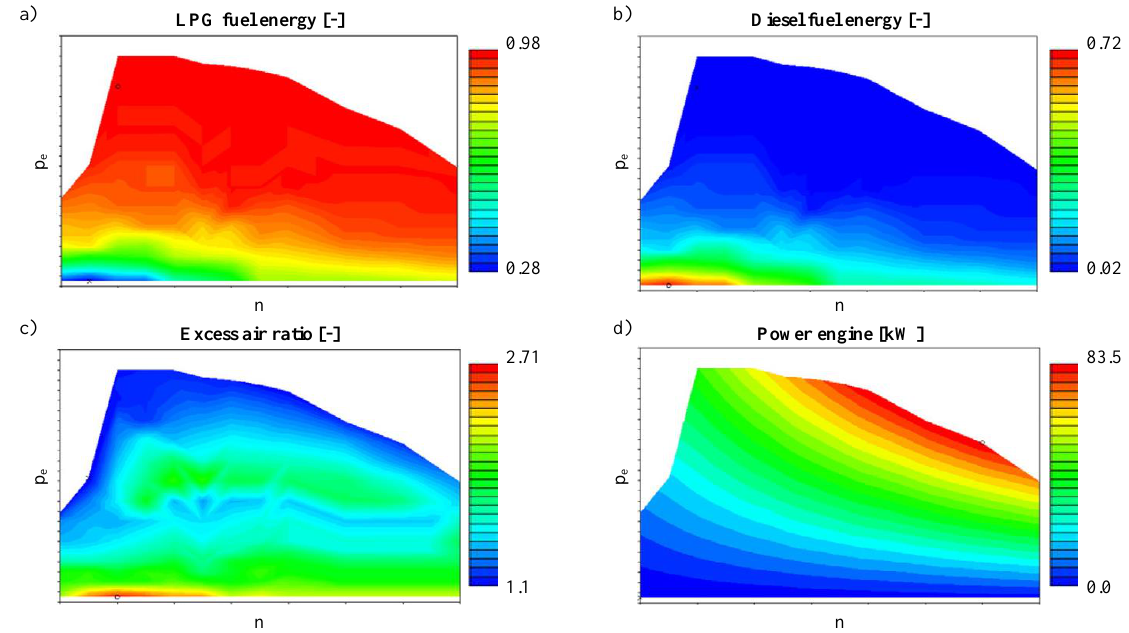
Fig. 11. Simulation analysis of the excess air coefficient overlayed on the general characteristics of an engine using a combined DF and LPG injection: a) LPG energy share, b) Diesel fuel energy share, c) excess air coefficient, d) engine power (reproduced from [7])